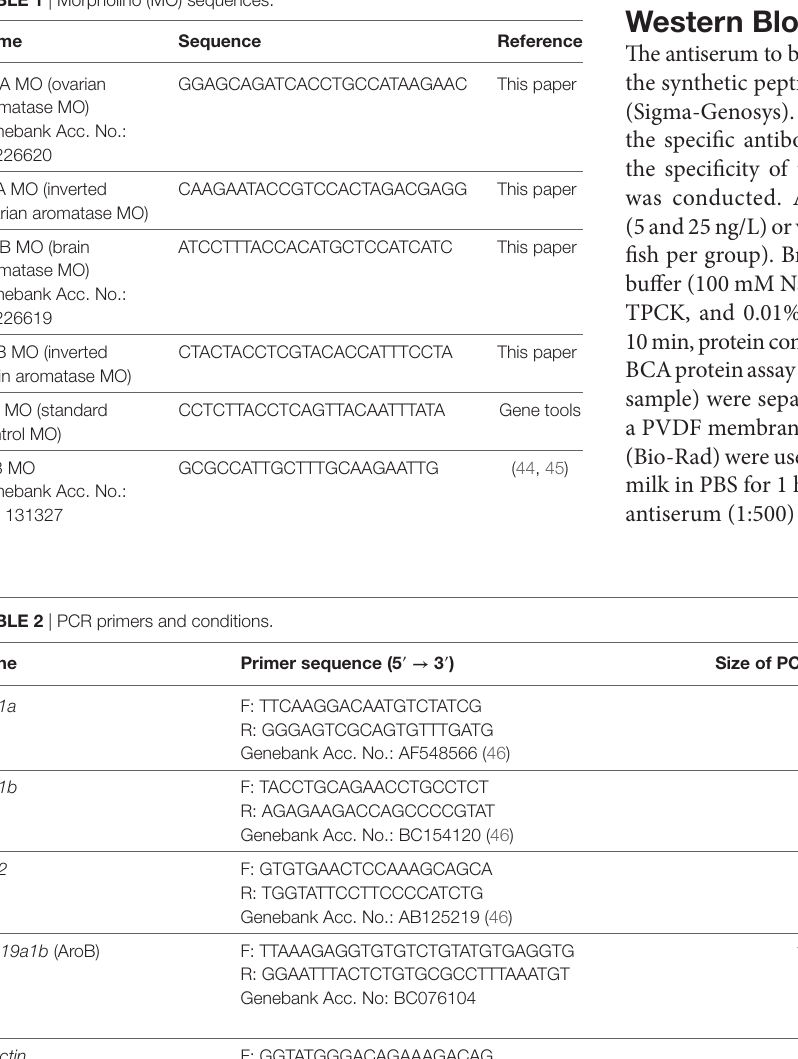
TaBle 1 | Morpholino (MO) sequences.